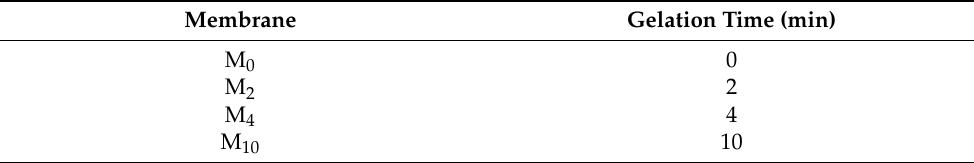
Figure 1. Schematic of preparation of PA6 membrane by phase inversion technique. Table 1. Elaboration parameters of PA6